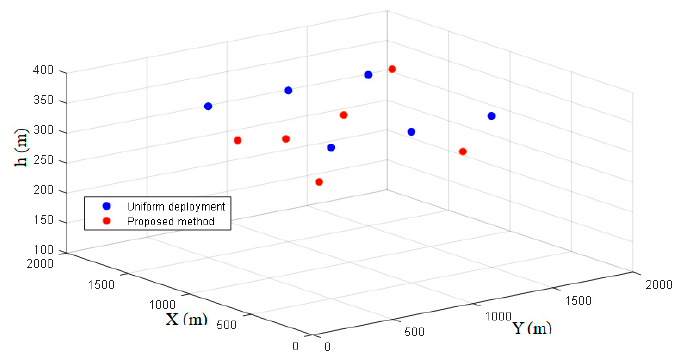
Figure 5. 3D locations of DBSs.